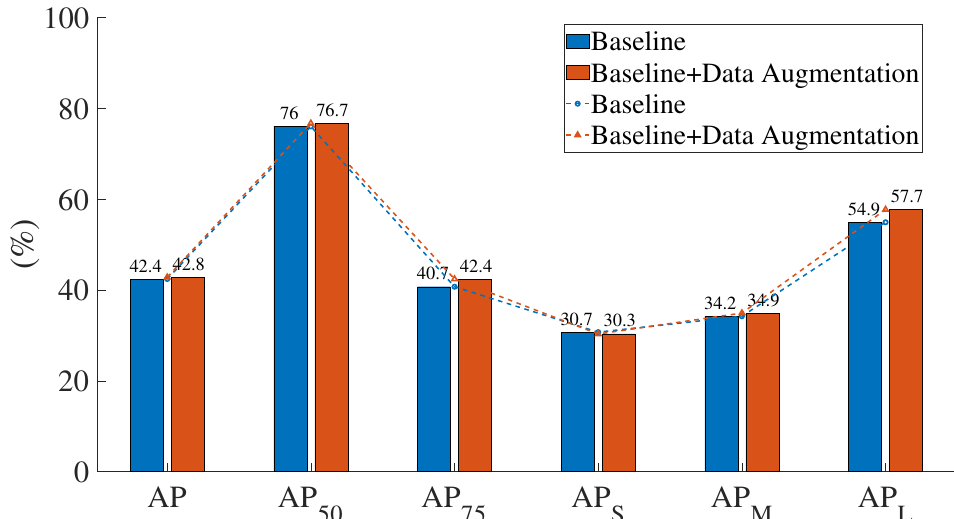
Figure 7. Comparison of the results before and after data augmentation.